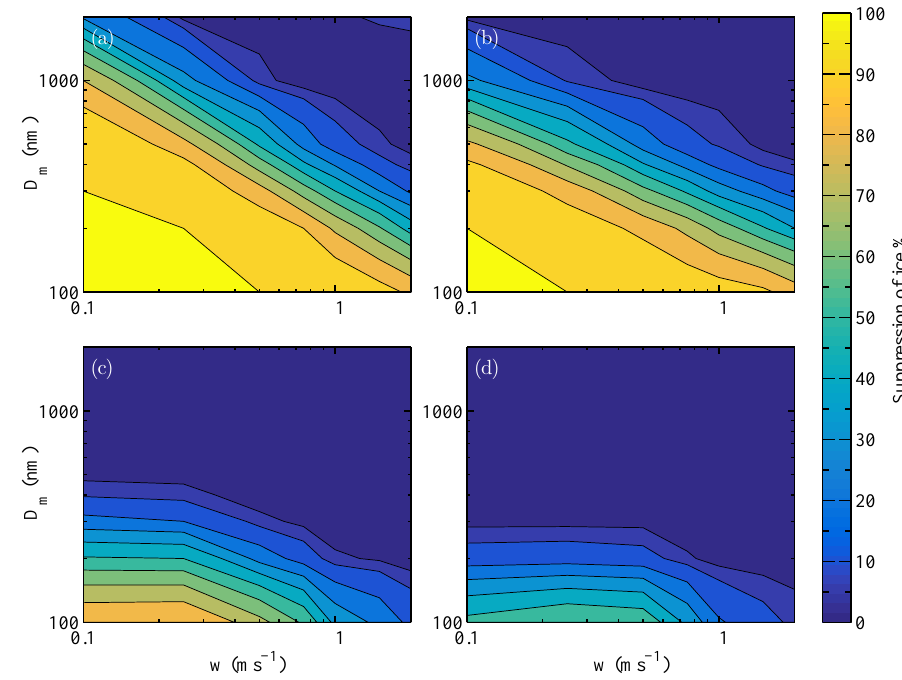
Figure 5. Same as Fig. 4 however the criteria for heterogeneous freezing in these results is M cw .